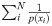
Calculation of multiplication factors from questionnaire and national surveillance data.Diagram illustrating the estimation of uncorrected (MFuncorrected) and spatially-corrected (MFcorrected) under-reporting multiplication factors. (Left) Events occurring between an outbreak on a farm and its report and confirmation through the national surveillance system of Peru. The probability of each event is shown in parenthesis, based on results from our surveys, national surveillance records and the literature (for FAT test). (Right) The derived multiplication factors are calculated from these probabilities. For MFcorrected, the spatial correction is applied to each outbreak by calculating probability p(x) of a farmer reporting a case, which is a function of its distance to the nearest reporting office. We show the value of the average MFcorrected based on confirmed outbreaks in 2014, with MFcorrected = ∑iN1p(xi), where N = total number of outbreaks and p(xi) = predicted reporting probability of outbreak i as a function of its distance xi to the reporting office.